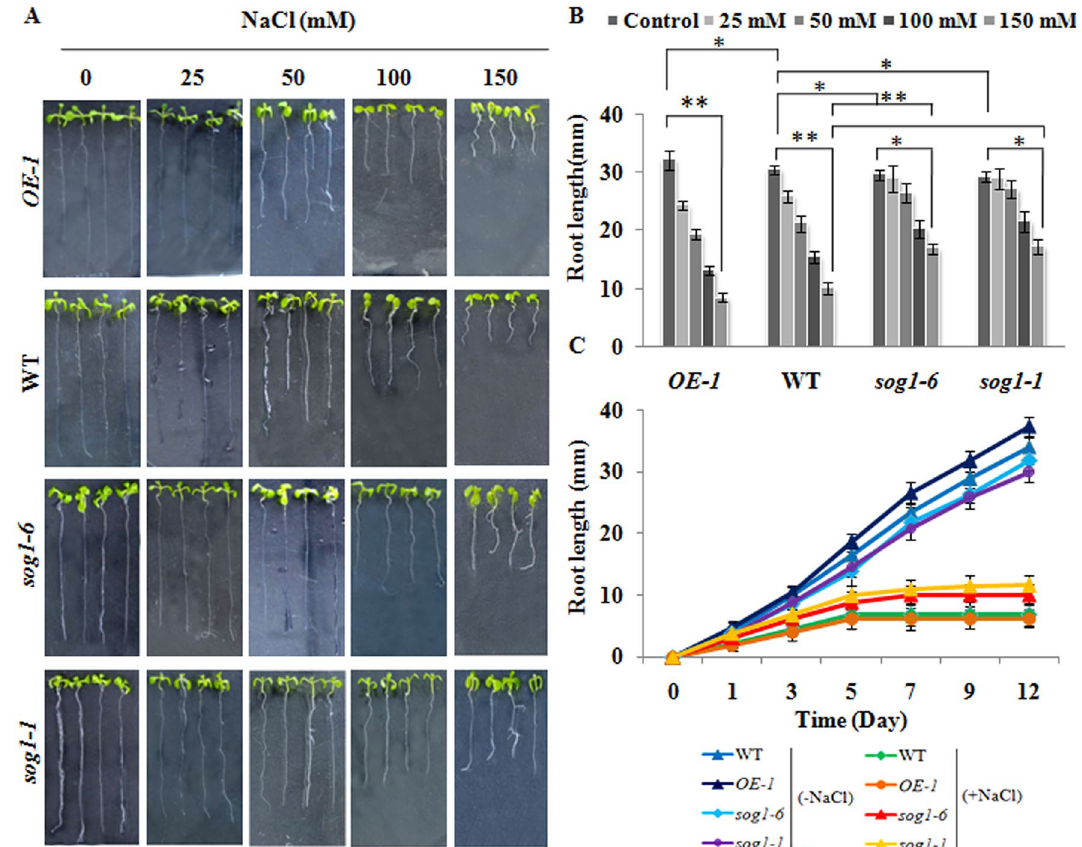
Figure 1. Phenotypic responses in presence of increasing salinity. ( A , B ) Determination of root growth in 12-days old OE-1 , wild-type (WT) , sog1-6 and sog1-1 mutant lines under untreated condition and in response to increasing salinity. ( C ) 12-days old seedlings of wild-type, OE-1 , sog1-6 and sog1-1 were treated without or with 150 mM NaCl and root growth was measured in 1-day interval. Three independent biological replicates for each genotype, each containing at least 10 plants, were analysed. The mean value of root length in individual experiment was determined and averaged subsequently for the three biological replicates. Error bar in the graphs represents ± SD. Asterisks represent statistically significant differences within a 5 and 1% confidence interval (* p < 0.05, ** p < 0.01), respectively based on one-way ANOVA factorial analysis indicating the genotype that differs significantly in primary root